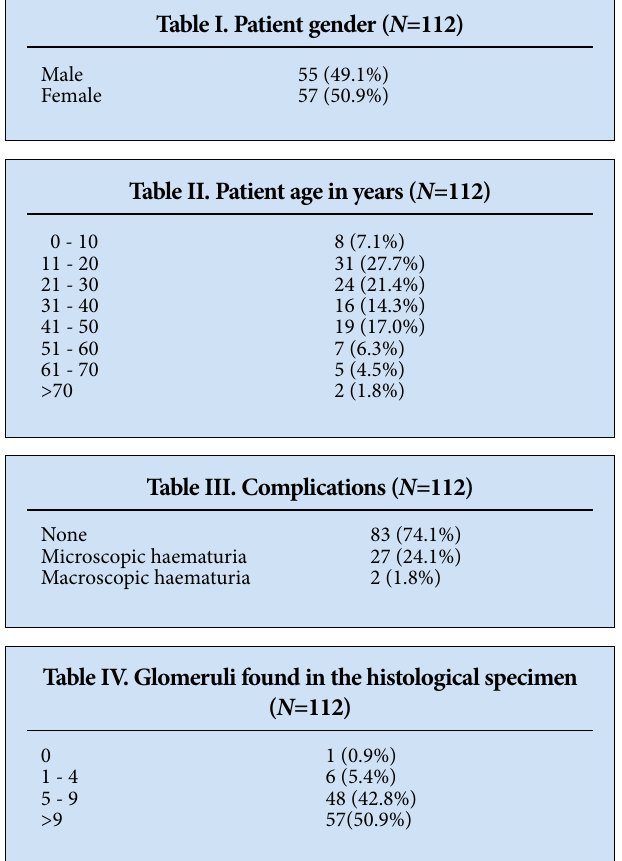
Table II. Patient age in years ( N= 112)